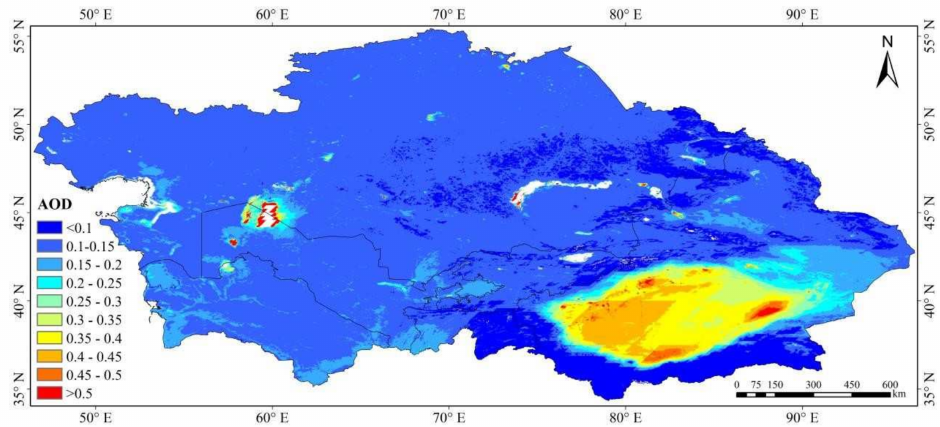
Figure 3. Average AOD distribution in Central Asia from 2001 to